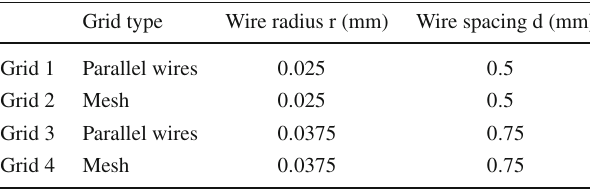
Table 2 The grid parameters of two different types of